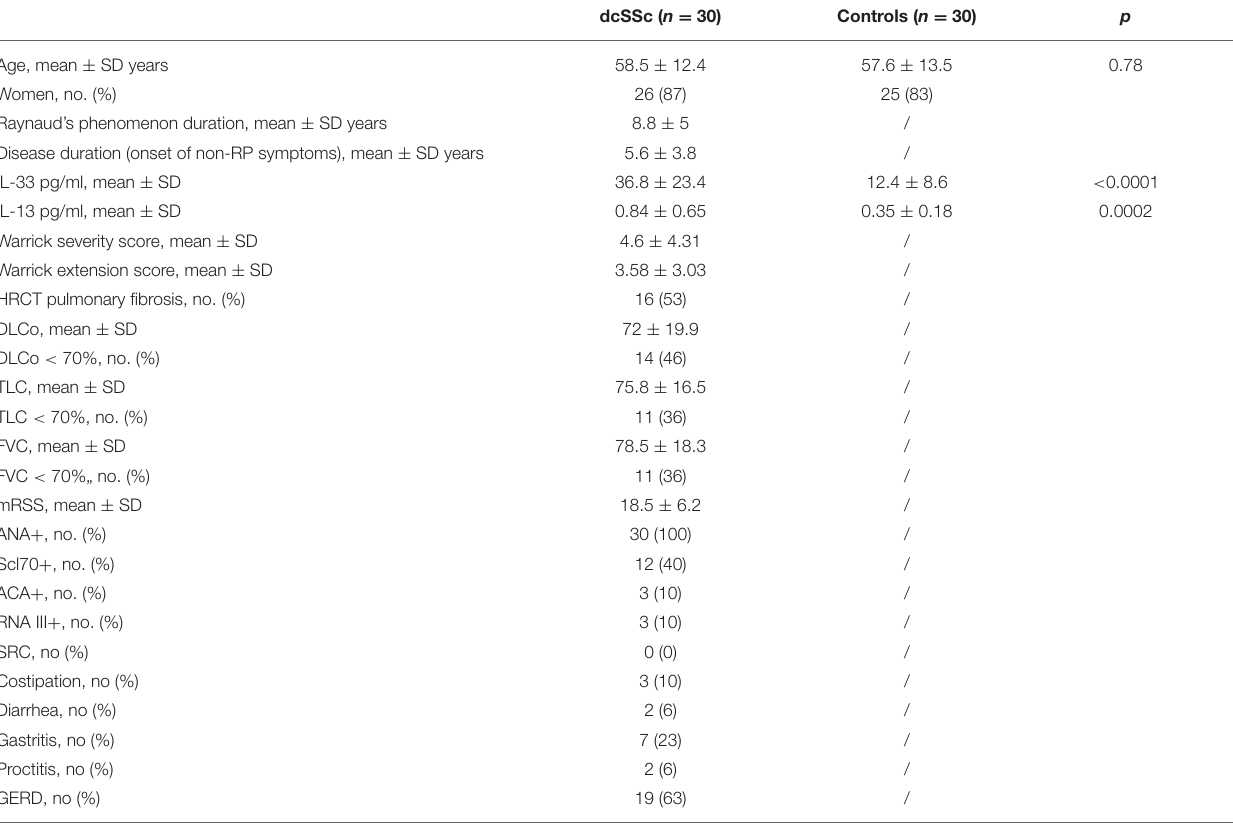
TABLE 1 | Demographics and outcomes of interest of systemic sclerosis patients and